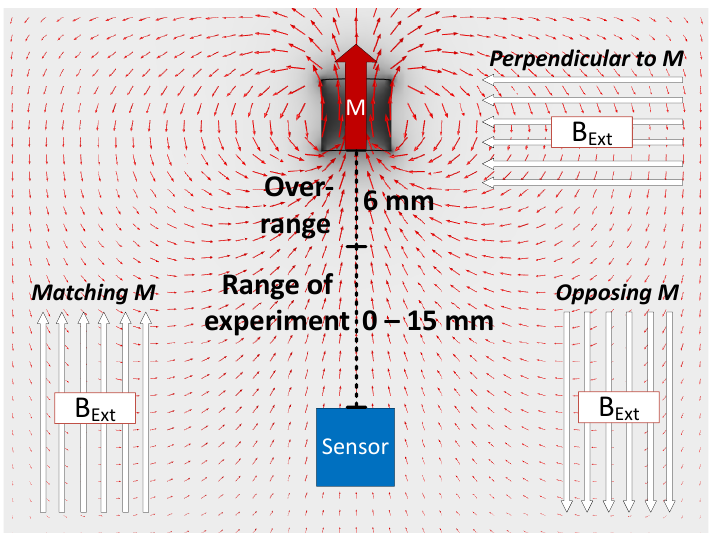
Figure 3. Principle of evaluating the influence of background magnetic field B BMF acting in vari- ous